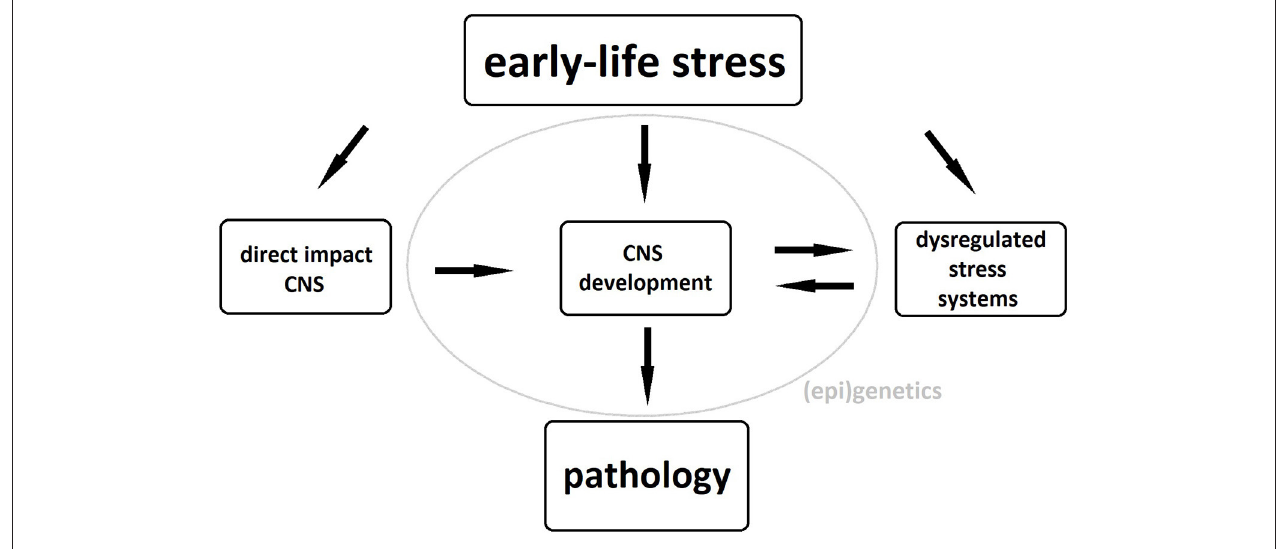
FIGURE 1 | Biological pathways underlying the association between early-life stress and psychopathology. CNS, central nervous